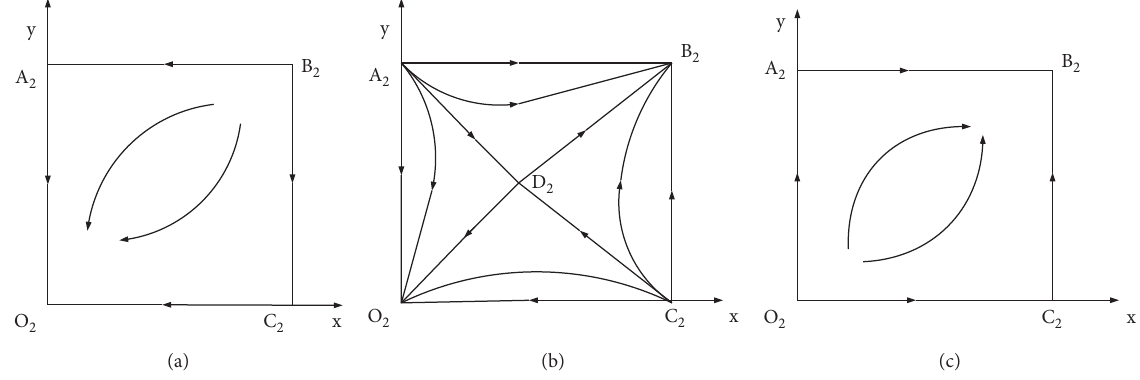
Figure 2: Phase diagram of system evolution with government